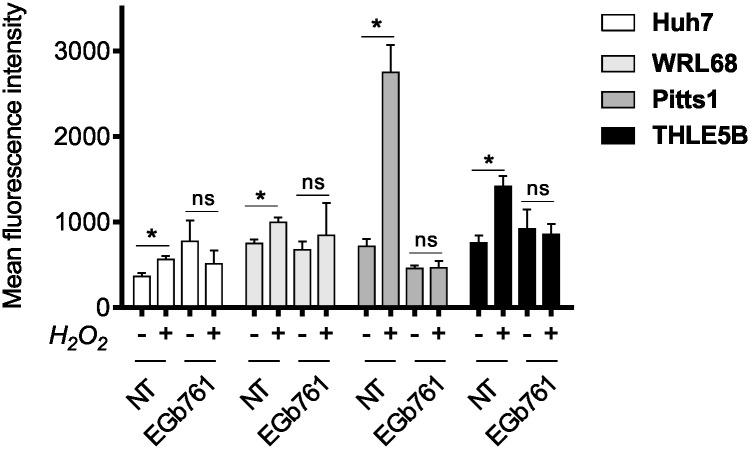
EGb761 exerts anti-oxidant activities.Basal (-) and H2O2-induced (+) changes in redox status were evaluated by flow cytometry using the ROS-indicator CM-H2DCF-DA in non-treated cells (NT) and after 72h exposure to EGb761. The data represent means DCF fluorescence intensity ± SEM of three independent experiments; *p<0.05, analyzed by student’s t-test.